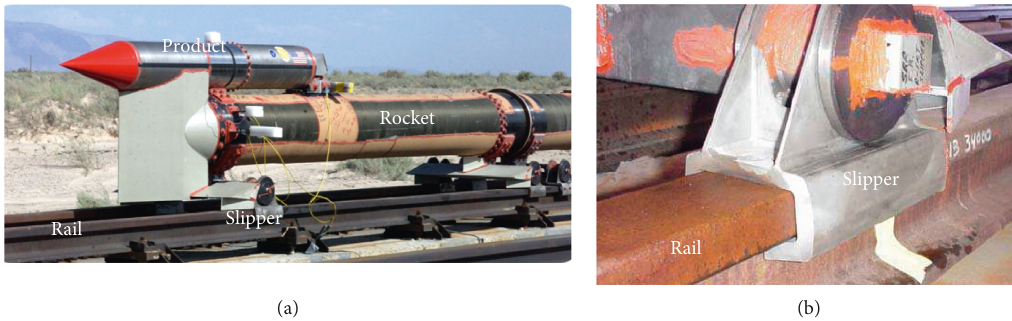
Figure 1: Rocket sled test system [2]. (a) A rocket sled waiting to be launched. (b) Mode of connection between a slipper and a